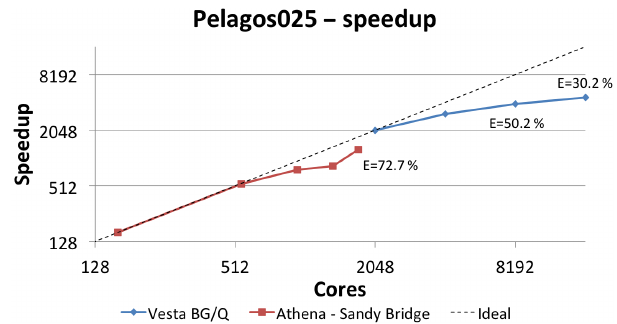
Figure 2. Scalability of the PELAGOS025 configuration: compari- son between the results obtained on ATHENA and VESTA. The red line represents the speedup of the model on ATHENA, the blue line on VESTA. The dashed line represents the ideal speedup.